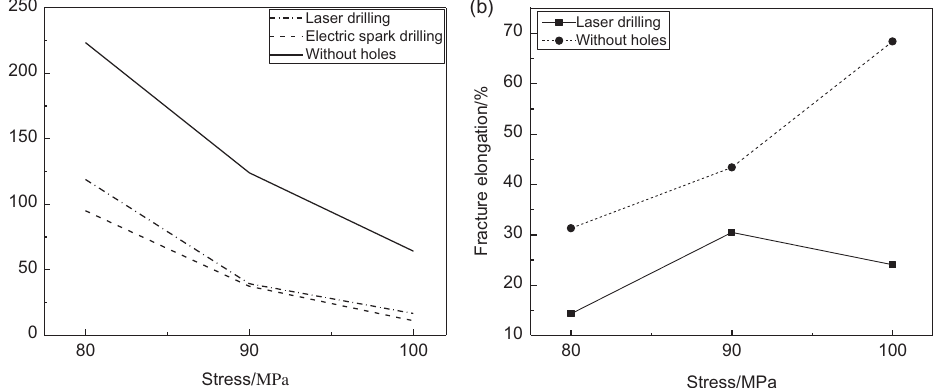
Figure 3: Creep test results: (a) the curve of average creep life versus stress and (b) the curve of fraction elongation versus